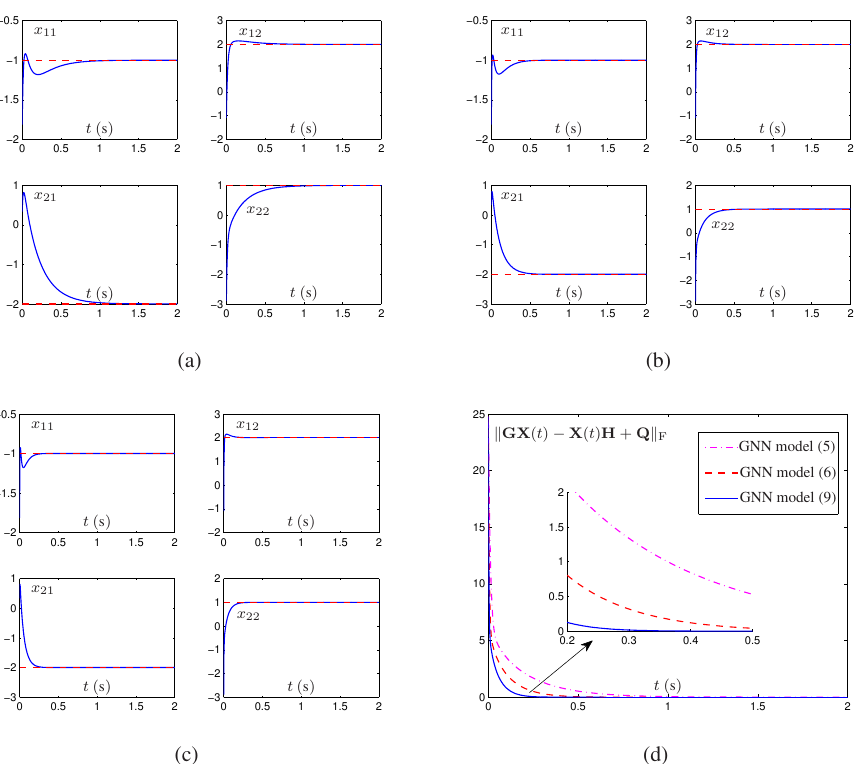
Figure 2. Convergence behaviors of neural state X ( t ) denoted by blue solid curves and residual error (cid:107) GX ( t ) − X ( t ) H + Q (cid:107) F . ( a ) Neural state X ( t ) of GNN model (5). ( b ) Neural state X ( t ) of GNN model (6). ( c ) Neural state X ( t ) of GNN model (9). ( d ) Residual error (cid:107) GX ( t ) − X ( t ) H + Q (cid:107) F of three GNN models.